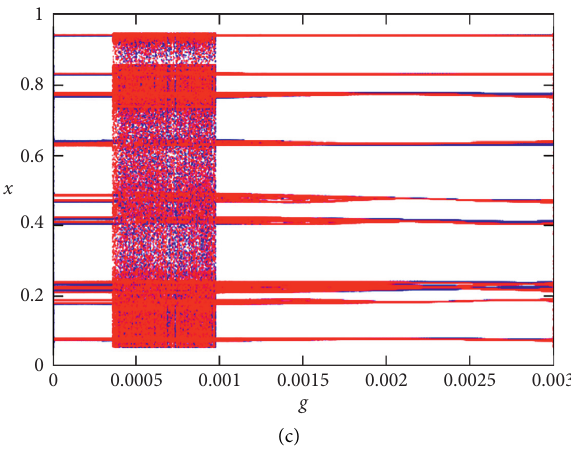
� √ − 1)/2, α � 0.28, and β � 0.04: 5